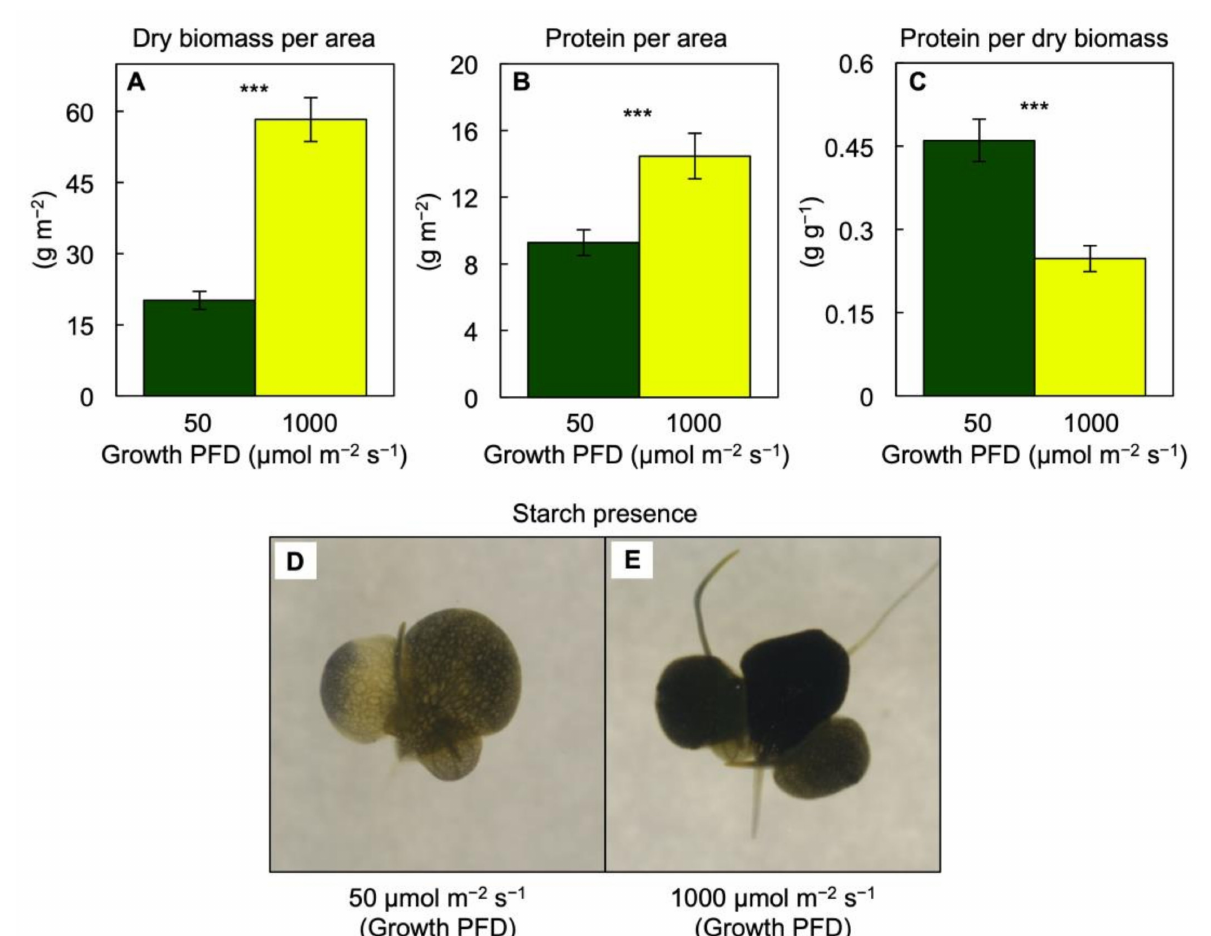
Figure 2. ( A ) Dry biomass per frond area, ( B ) protein per frond area, ( C ) protein per dry biomass, and ( D , E ) presence of starch (detected via diluted iodine-potassium iodide solution) in Lemna gibba plants grown under 50 (green) or 1000 (yellow) µ mol photons m − 2 s − 1 . Mean values ± standard deviations; n = 4. Significant differences between the growth PFDs are denoted by asterisks; *** = p < 0.001. Dimensions of each image ( D , E ) are 1 cm × 1